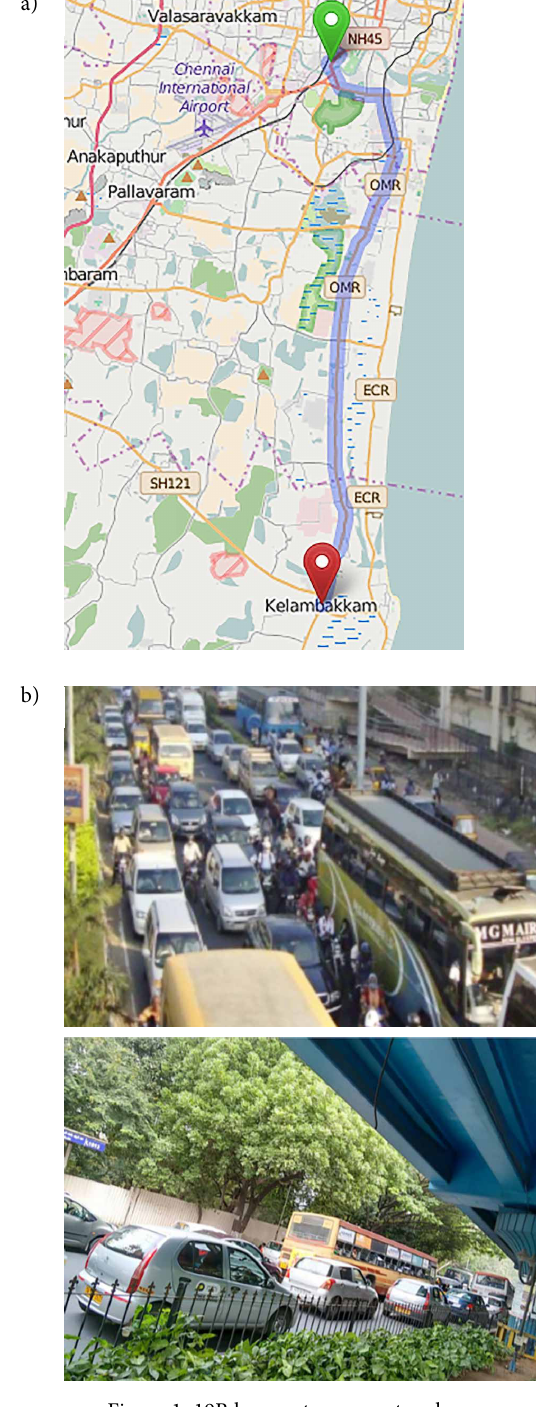
Figure 1. 19B bus route: a – route